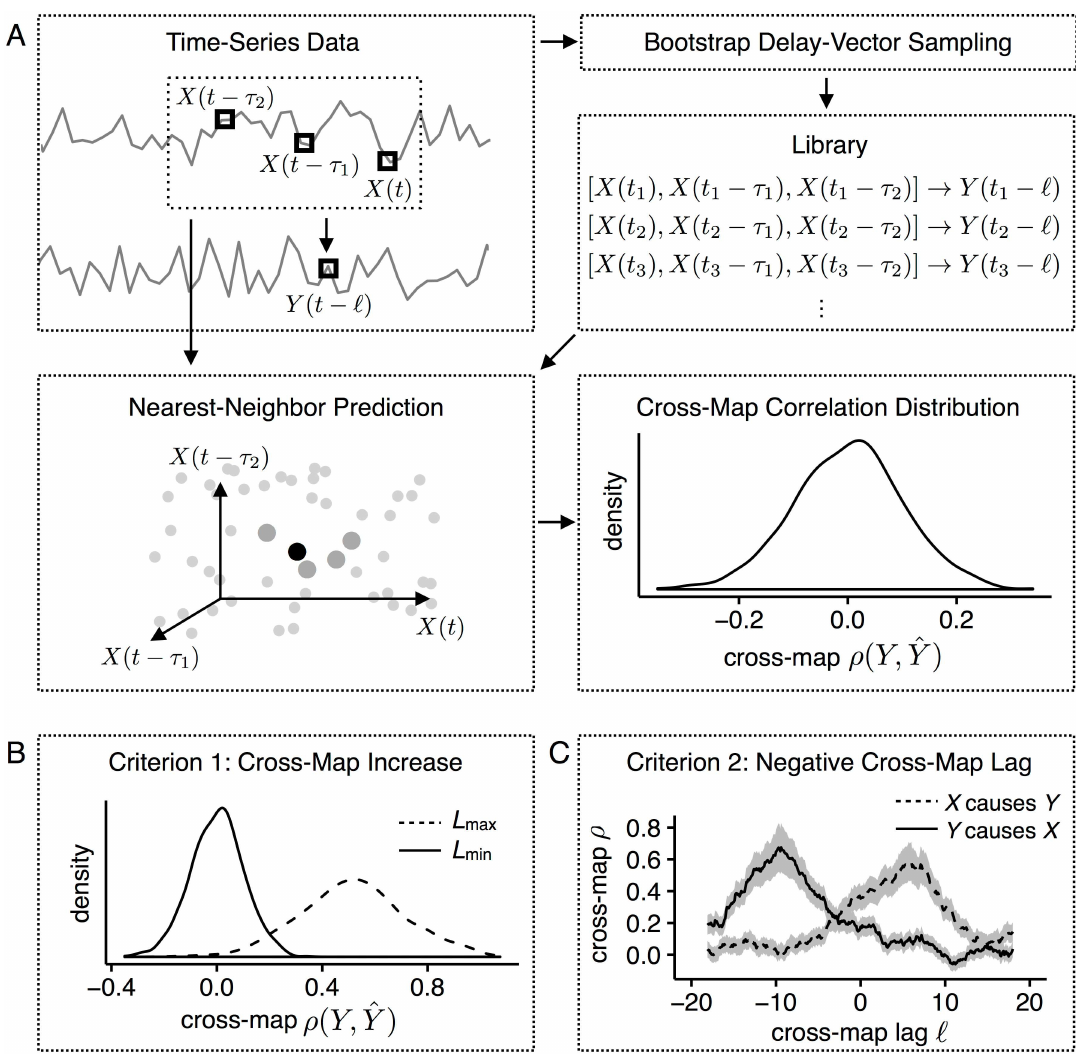
Fig 1. Summaryof criteria for detecting causality. (A) Schematic of cross-map algorithmfor testing Y ! X . Delay vectors in X , mappedto values in Y with lag ℓ , are bootstrap-sampledto construct a prediction library. For each delay vector in X , reconstructed values ^ Y are calculatedfrom a distance-weightedsum of Y values from nearest neighborsin the library. Many sampledlibrariesyield a distribution of cross-map correlationsbetweenactual Y and reconstructed ^ Y . (B) Criterion 1 (cross- map increase). Bootstrap distributionsof cross-map correlationare calculatedat minimum and maximum library sizes with ℓ = 0; causality is inferred if the correlationat L max is significantly greater than the correlationat L min . (C) Criterion 2 (negative cross-map lag). Cross-map correlationsare calculatedacross different values of ℓ . Causalityis inferred if the highest cross- map correlation for negative ℓ is positive and significantly greater than the highestvalue for nonnegative ℓ